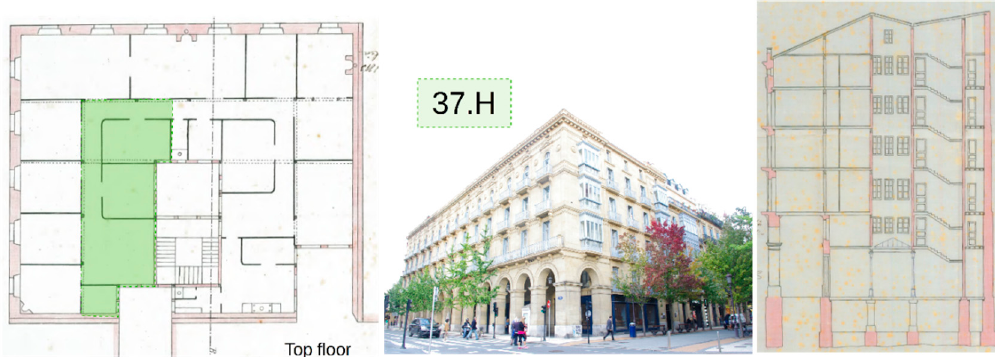
Figure A8. Floor plans of the blower door tests performed in the Loiola 14 case study.